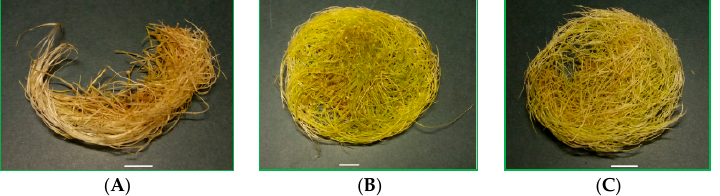
(Figure 2A). Figure 1. R. carthamoides transformed roots cultured in 50 mL of liquid WPM medium in a 300 mL Erlenmeyer flask in light conditions (16/8-h light/dark photoperiod) on a rotary shaker at 80 rpm ( A ) without sucrose, supplemented with ( B ) 3% sucrose, and ( C ) 7% of sucrose. Bar = 1 cm. The dry weight of R. carthamoides transformed roots increased with the sucrose con- centration up to 7% and achieved a maximal value of 31.17 g L − 1 (Figure 2B). The growth index (initial weight to final biomass) also peaked at 7% sucrose, increasing 19-fold. The dry weight was slightly lower at sucrose concentrations of 3% and 5% (29.34 g L − 1 and 28.81 g L − 1 , respectively) (Figure 2B).